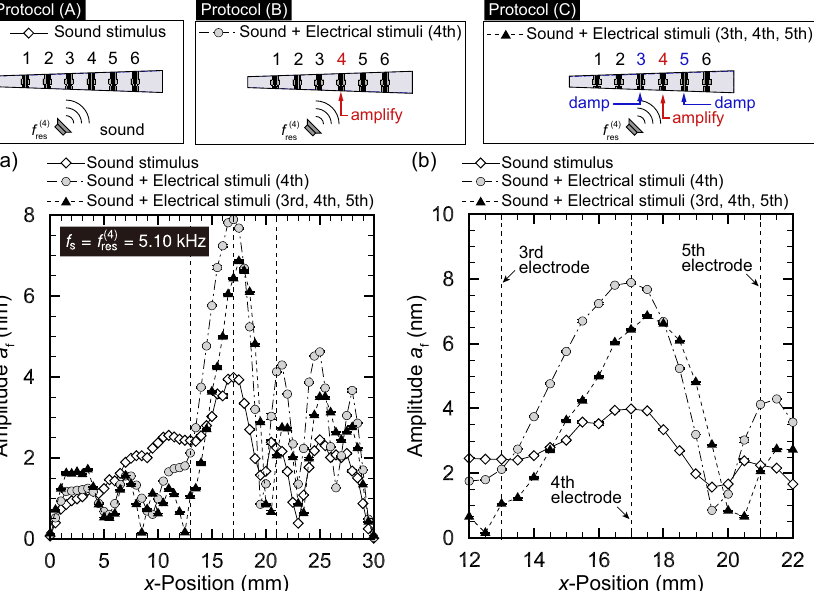
Figure 5. Vibration amplitude distribution for protocol (A): only sinusoidal sound stimuli with f s = 5.10 kHz; protocol (B): sound and electrical stimuli applied to the fourth electrode; and protocol (C): sound and electrical stimuli applied to the third to fifth electrodes. ( a ) Entire view and ( b ) magnified version near x ( 4 ) . Protocol (B) succeeded in amplifying a f at resonant position x ( 4 ) = 17